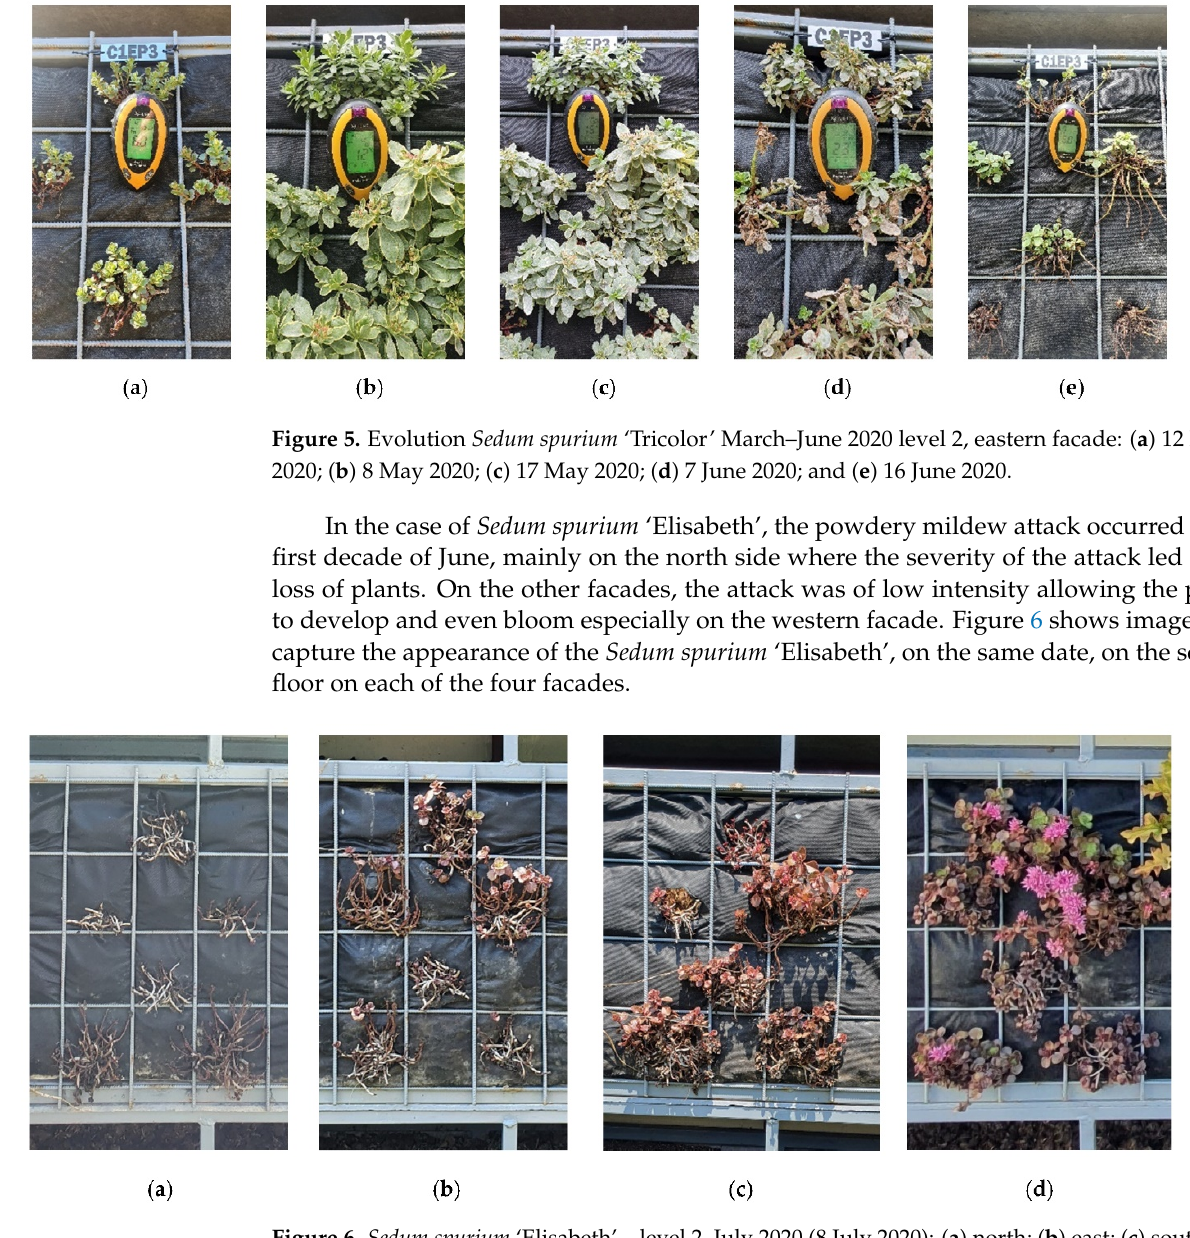
Figure 6. Sedum spurium ‘Elisabeth’—level 2, July 2020 (8 July 2020): ( a ) north; ( b ) east; ( c ) south; and ( d ) West.